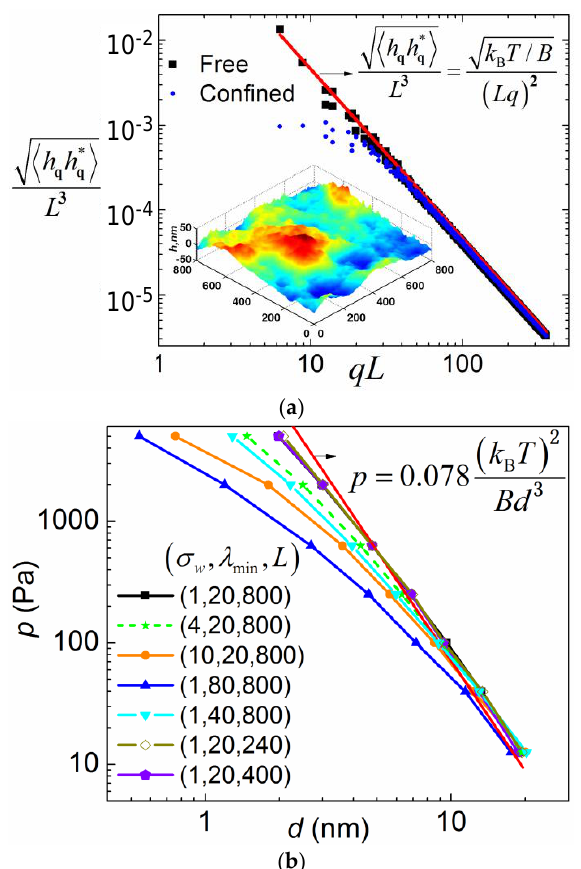
Figure 2. ( a ) Free membrane fluctuation spectrum. Simulation parameters are as follows L = 800 nm, k B T = 4.3 pN·nm, B = 20 pN·nm ~ 5 k B T , η = 0.06 Poise, time step Δ t = 0.5 ns, total simulation time t total = 1